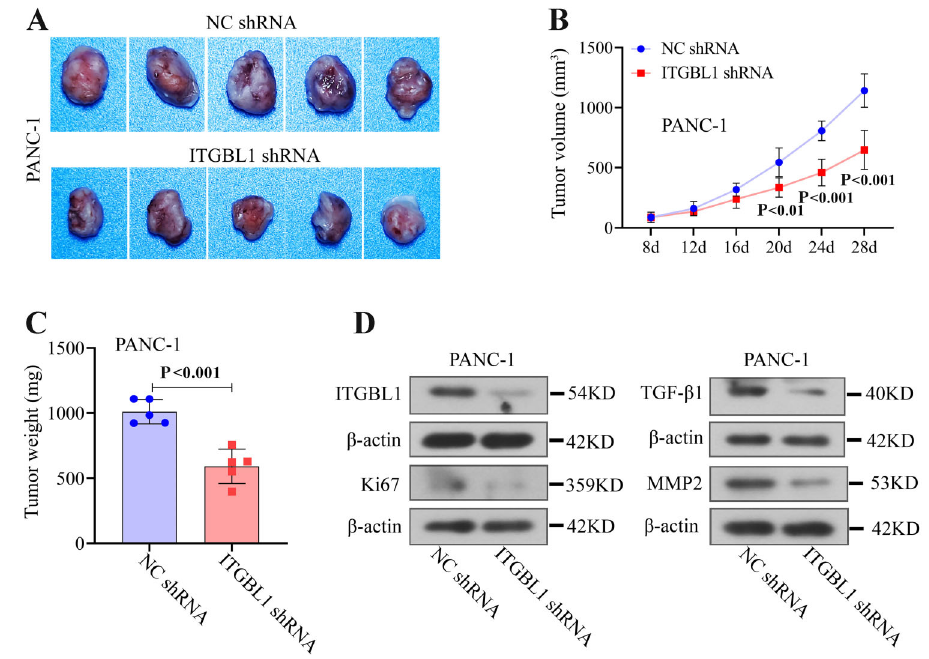
Figure 7. ITGBL1 silencing suppressed tumor growth in vivo. A – C , Tumor images, volumes, and weights of mice injected with ITGBL1- silenced cells or its control (NC). D , Protein expression levels of ITGBL1, Ki67, TGF- b 1, and MMP2 in tumor tissues. Data are reported as means ± SD for N=5 (ANOVA and t